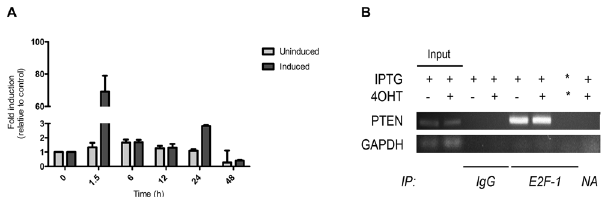
Figure 1. PTEN transcription is directly regulated by Rb/E2F complexes. ER-dnE2F1 cells were treated IPTG and with 4-OHT to induce Rb/E2F-associated apoptosis. Uninduced control cells were left untreated. (A) Total RNA was isolated at the indicated time points following induction of apoptosis and used for qPCR analysis for two independent experiments performed in triplicate. Results are expressed as the mean + standard deviation. (B) Chromatin was isolated from the cells, sheared and immunoprecipitated with control mouse IgG or E2F1 antibody. A , 300 bp sequence within the PTEN promoter region was amplified by PCR. GAPDH was used as control. ( 2 ) Untreated; ( + ) Treated; (NA) No antibody negative control; (*) No chromatin negative control.